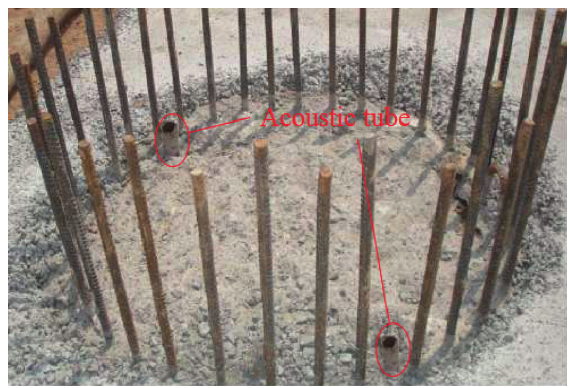
Figure 10: Layout of the acoustic